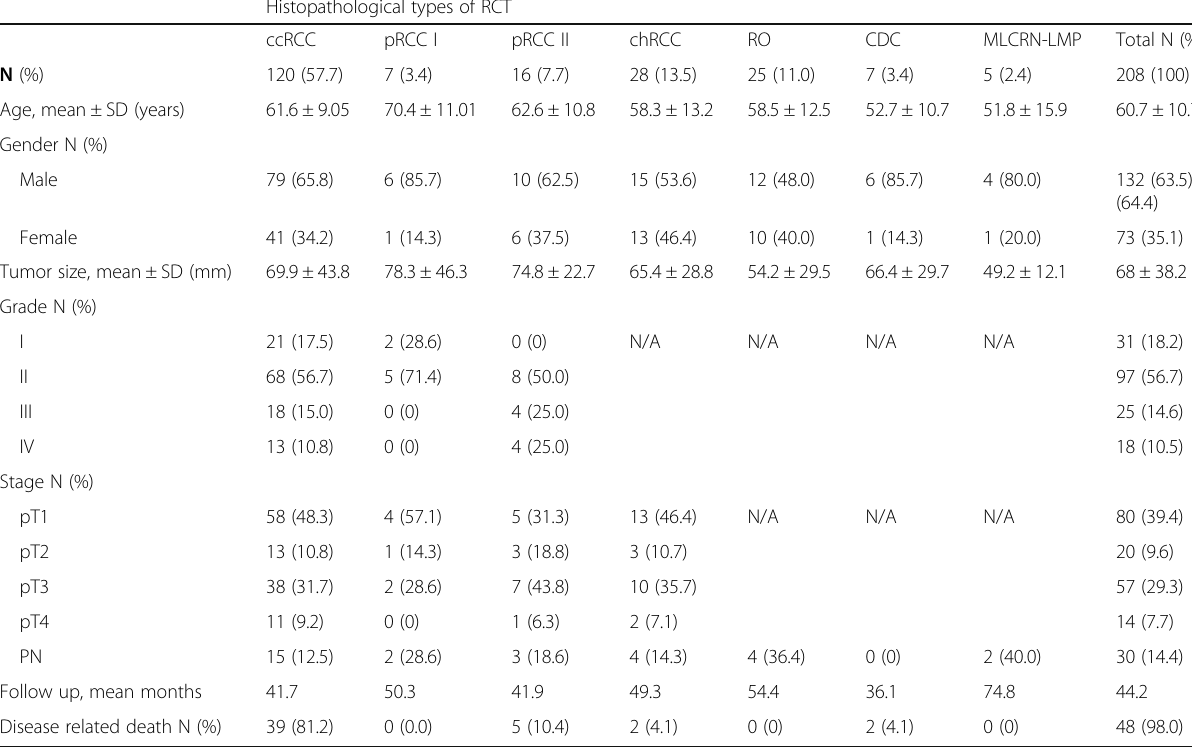
Table 1 Patients ’ demographics and tumor characteristics Histopathological types of